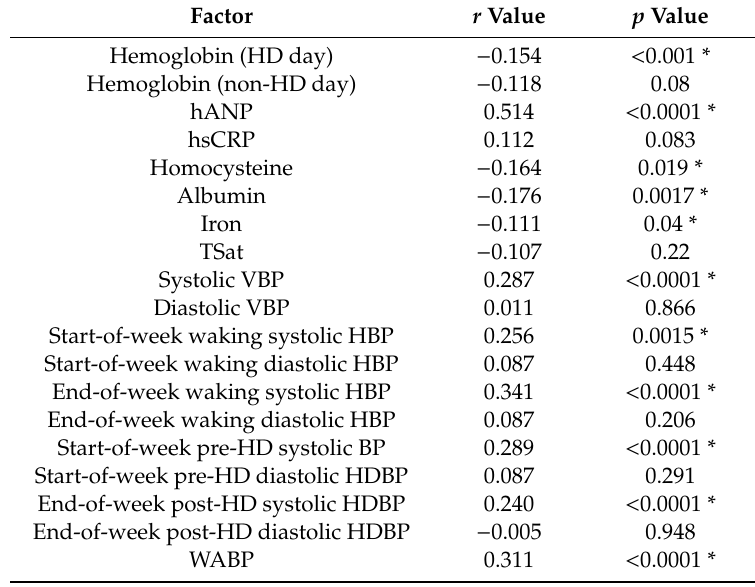
Table 4. Univariate analysis of factors associated with LVMI beyond 12 months after HD initiation.